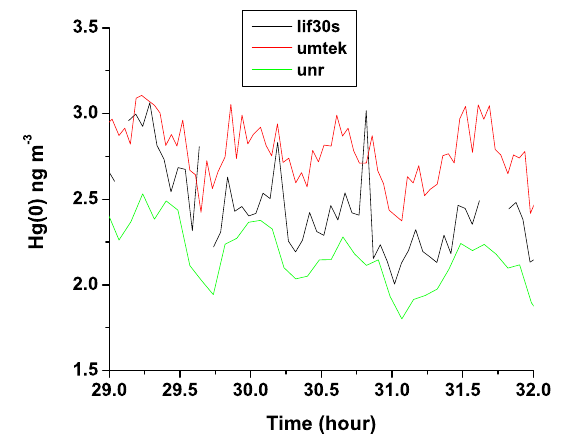
Figure 5. A section of the 22h sampling period from 1 and 2 September. Comparison of the UM (red line) and UNR (green line) Tekrans with the UM 2P-LIF (black line) concentrations. The concentrations for each instrument are scaled to force agreement during the second manifold spike at hour 33. These are the data from Fig. S3 with the concentration scale expanded to show only ambient data between hours 29 and